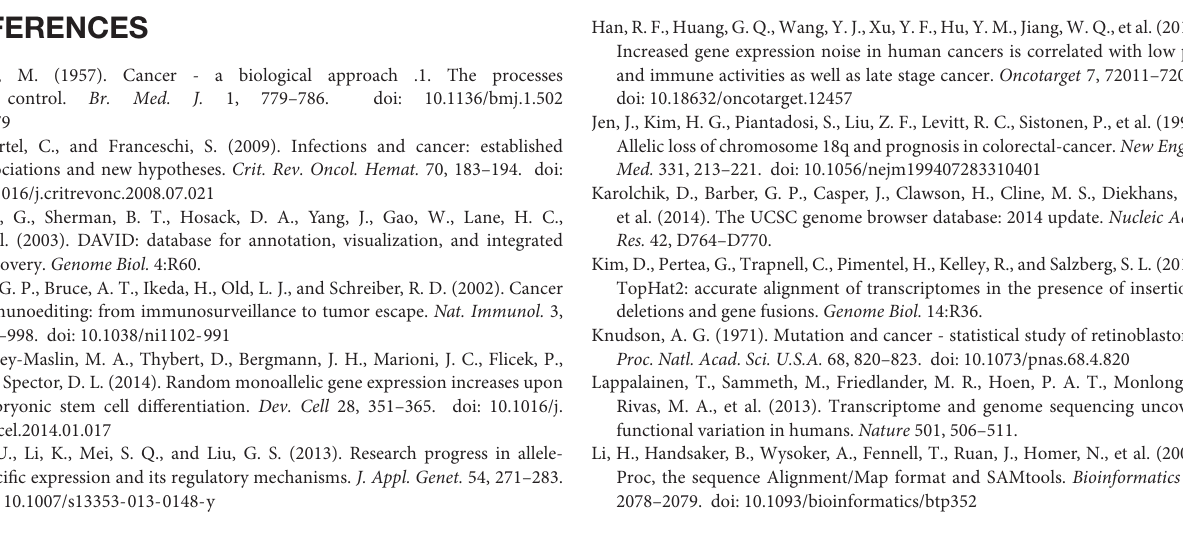
FIGURE S1 | Distribution of the average number of exonic heterozygous SNPs in every gene. FIGURE S2 | Proportions of AEI in adjacent normal tissue (green) and tumor tissue (yellow) samples in South Korean samples. Proportions of AEI in tumor samples were significantly higher than those in adjacent samples ( p -value = 5.55 × 10 − 14 ). FIGURE S3 | (A) The proportion of allele ratio bias in tumor tissues (yellow) and adjacent tissues (green); the proportion in tumor tissues was significantly larger than that in adjacent tissues ( p- value = 0.0282). (B) The proportion of AEI in genes that did not show allele ratio bias in tumor tissues (yellow) or adjacent tissues (green); the proportion of AEI in tumor tissues still showed a significant increase ( p- value = 1.06 × 10 − 8 ). FIGURE S4 | Probability density distributions of the frequency of AEI in genes from tumor tissues and from adjacent tissues. FIGURE S5 | The results showed a negative correlation between site conservation and the frequency of AEI in adjacent tissues (Cor = − 0.06, p -value = 8.96 × 10 − 5 ) (A) and a positive correlation between site conservation and the frequency of AEI in tumor tissues (Cor = 0.05, p -value = 8.06 × 10 − 4 ) (B) in South Korean samples. FIGURE S6 | The result showed a positive correlation between dN/dS and the frequency of AEI in adjacent tissues (Cor = 0.04, p -value = 0.01) (A) , but a correlation between dN/dS and the frequency of AEI in tumor tissues ( p -value = 0.91) (B) could not be observed. FIGURE S7 | A significant increase in the proportion of AEI in genes with non-synonymous SNPs, compared to those with synonymous SNPs, could be observed in adjacent tissues ( p -value = 0.00665) but could not be found in tumor tissues ( p -value = 0.388) in South Korean sample. FIGURE S8 | The proportion of allele ratio bias in tumor tissues and adjacent tissues and the influence of the functional onsequence of SNPs on the allele ratio could not be observed in either tumor tissues ( p- value = 0.699) (A) or adjacent tissues ( p -value = 0.150) (B) . An analysis of the proportions of AEI in genes did not show allele ratio bias with synonymous and non-synonymous SNPs in tumor tissues or adjacent tissues, and the promotion of AEI in genes with non-synonymous SNPs still existed in adjacent tissues ( p- value = 0.01105) (D) but not in tumor tissues ( p -value = 0.81) (C) . FIGURE S9 | After removing potential RNA editing sites and analyzing the proportions of AEI in genes with synonymous and non-synonymous SNPs in tumor tissues and adjacent tissues, the promotion of AEI in genes with non-synonymous SNPs still existed in adjacent tissues ( p- value = 0.0111) (B) but not in tumor tissues ( p- value = 0.413) (A) . The results indicated that RNA editing was not the only factor that changed allele